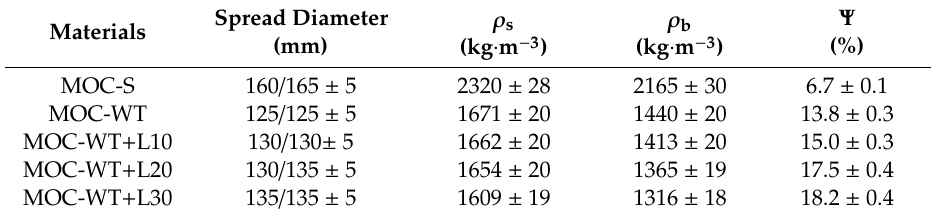
Table 4. Workability of fresh mixtures and macrostructural parameters of hardened composites.